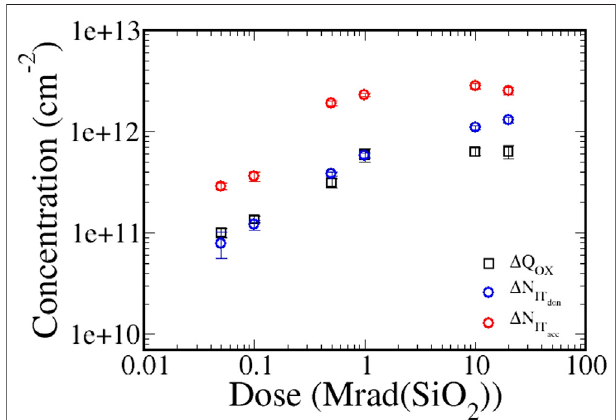
FIGURE 1 | Radiation induced oxide charge density increase Δ Q OX (cm − 2 ) and acceptor-/donor-like integrated interface trap states density increase Δ N IT (cm − 2 ) depending on the irradiated dose. They have been obtained by averaging measurements performed on FBK MOS capacitors, gated-diodes and MOSFETs realized on both p-type and n-type substrates. No bias during irradiation.